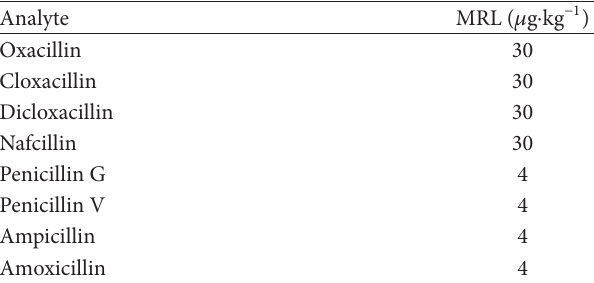
Figure 1: General structure of penicillins (R = lateral amino chain). Table1:MRLsestablishedbyCommissionRegulation(EU)number 37/2010 for penicillins residues in